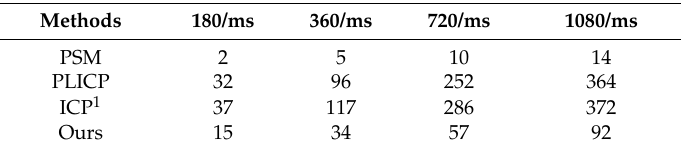
Table 4. The results of computation